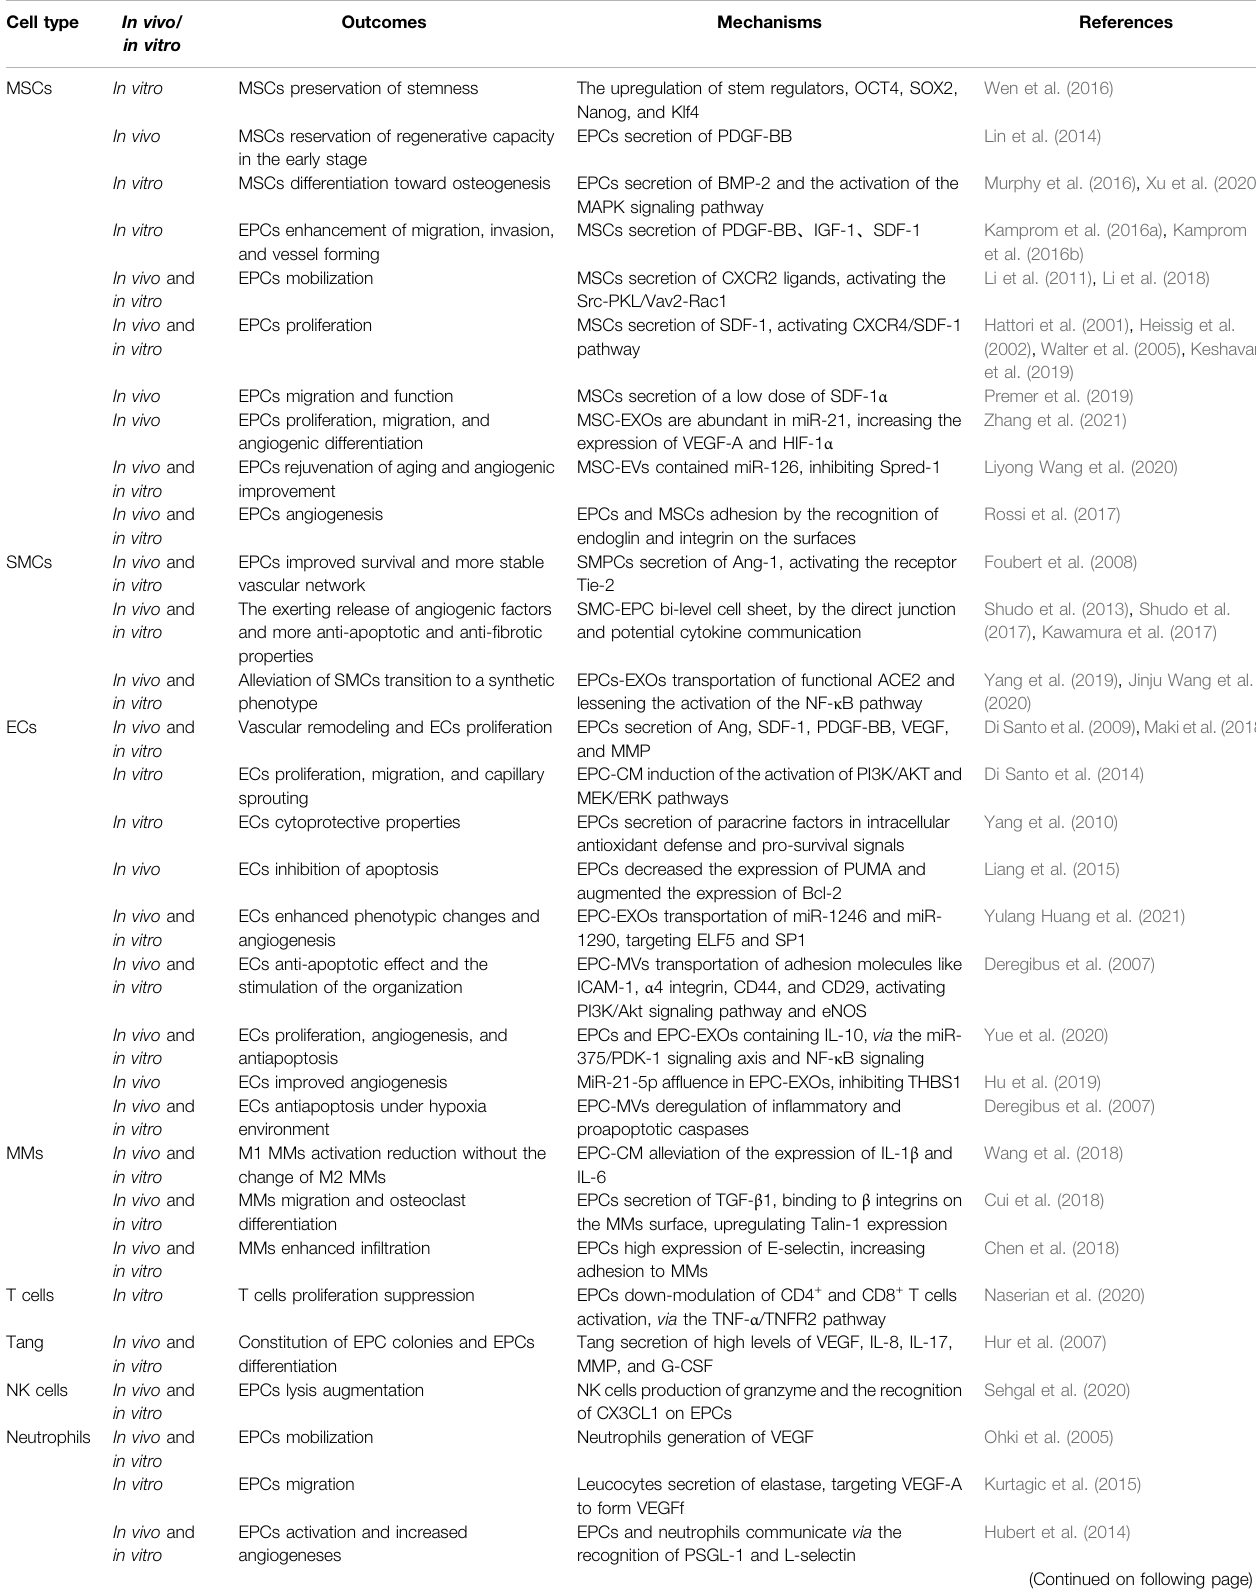
TABLE 1 | Outcomes and mechanisms of interaction between EPCs and other cells in bone